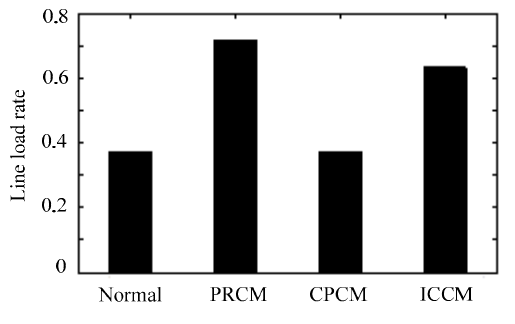
Figure 5. Load rates of lines 4–31.